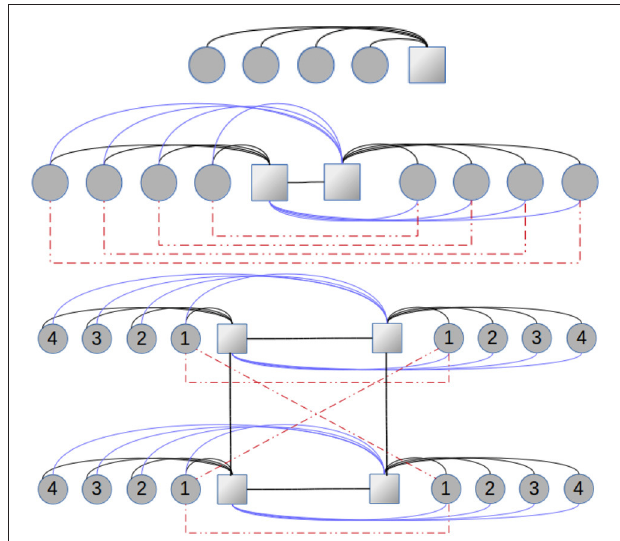
FIGURE 1 | Graphic representation of Hamiltonian Equation (2) corresponding to the impurity problem for the one, two, and four-site cellular DMFT. The circles (squares) represent the non-interacting (interacting/impurity) sites. The red lines correspond to the λ IJ q parameters between bath sites q related to impurities I and J (they are the only hybridization between the baths related to different impurities). The blue lines are the υ IJ q with I are the υ II q . In the bottom scheme we omit some obvious connections for